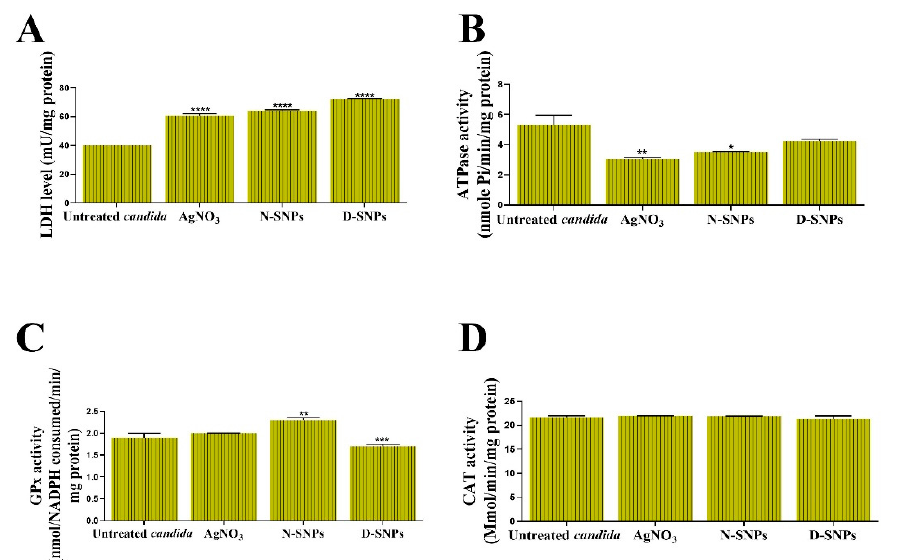
Figure 2. The influence of AgNO 3 , N-SNPs, and D-SNPs on Candida albicans enzyme activity. ( A ) Lactate dehydrogenase (LDH), ( B ) adenosine triphosphatase (ATPase), ( C ) glutathione peroxidase (GPx), and ( D ) catalase (CAT). Data were collected from at least three independent assays and are presented as means ± SEM. **** p < 0.0001, *** p = 0.0001, ** p < 0.001, and * p = 0.01 vs. untreated C. albicans .